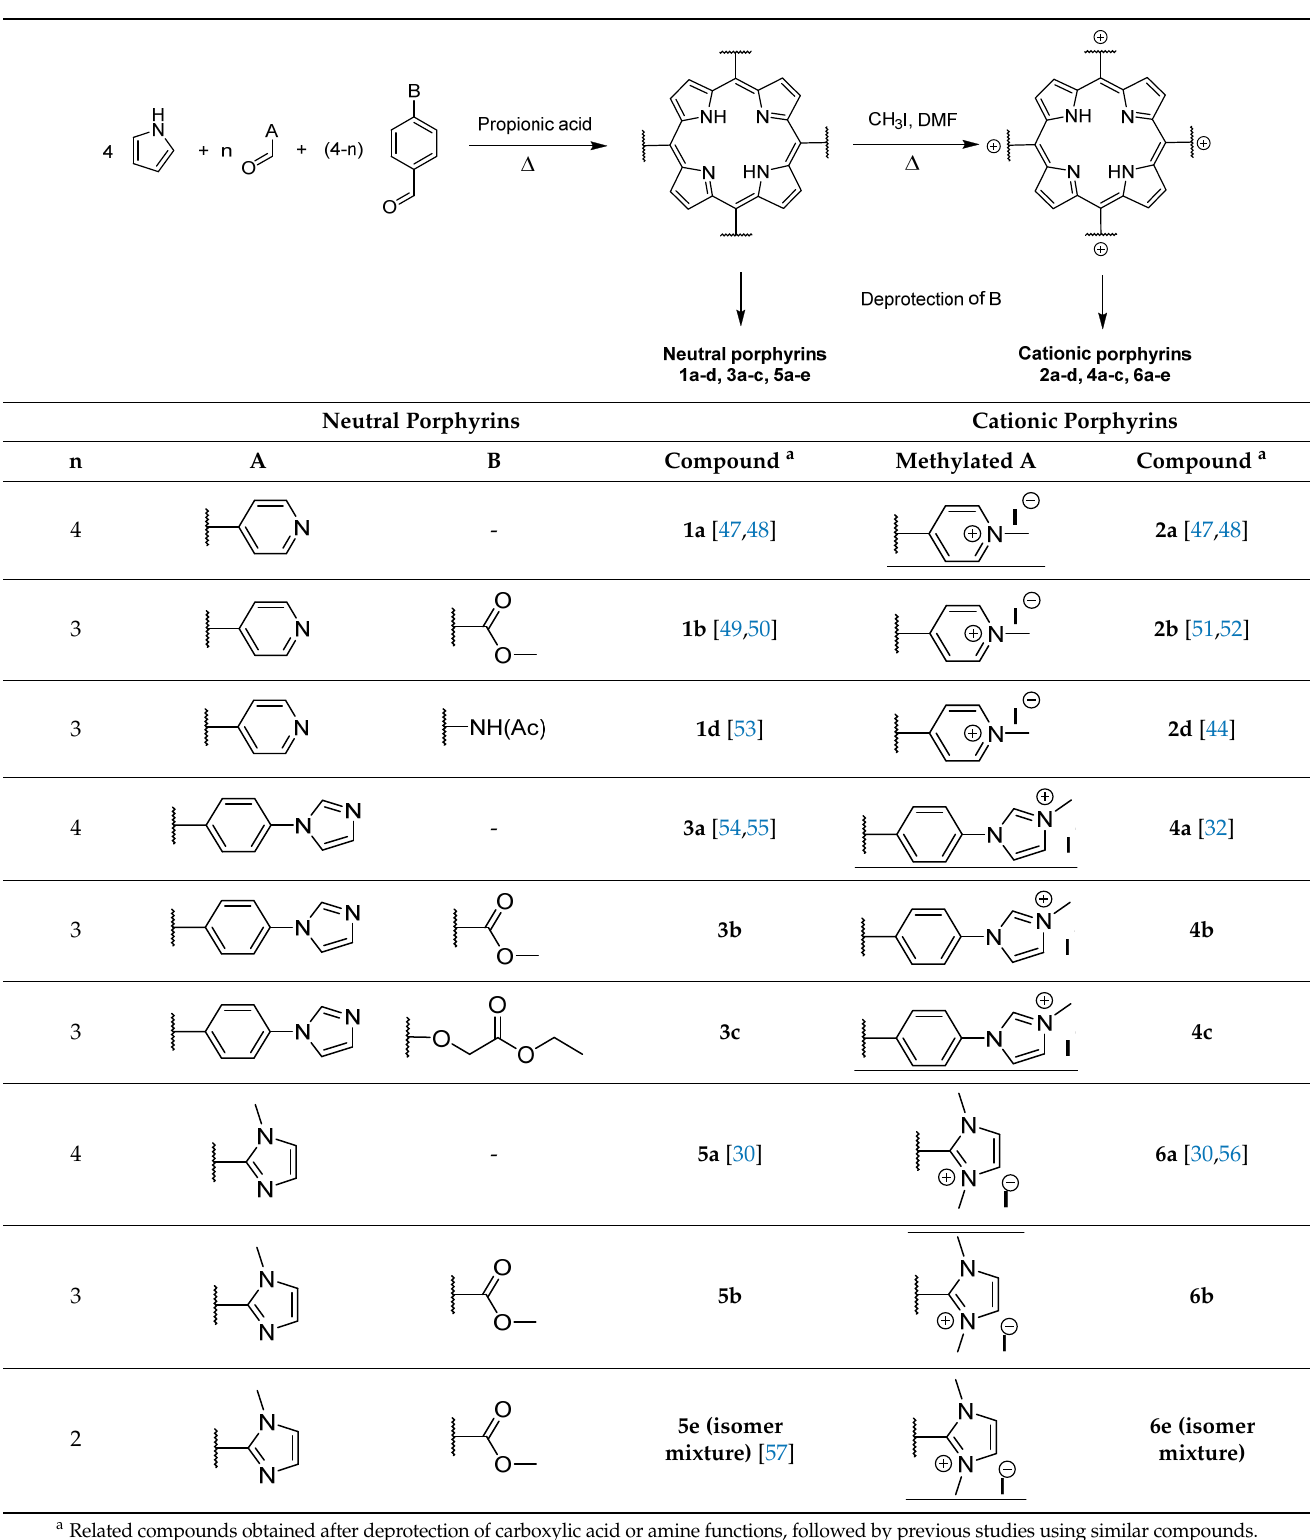
Table 1. Structures of neutral and cationic synthetized porphyrins.